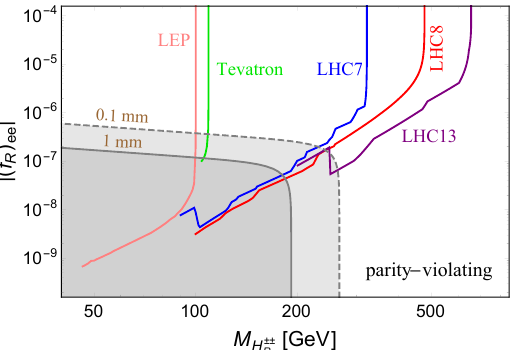
Figure 21 . Lower limits on M in the parity-violating LRSM from the e (cid:6) e (cid:6) data in (cid:12)gure 12, H (cid:6)(cid:6) R as functions of the Yukawa coupling j ( f R ) ee j . All the regions above the curves are excluded. The darker and lighter gray regions correspond respectively to the lifetime c(cid:28) 0 ( H (cid:6)(cid:6) ) > 1 mm and R 0.1 mm; within these regions the prompt dilepton limits are not applicable.